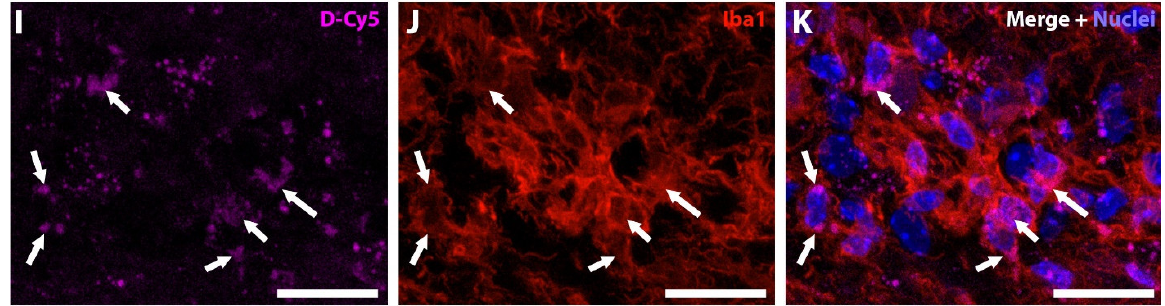
Figure 6. Dendrimer-Cy5 (D-Cy5) is targeted to areas of neuroinflammation. ( A – D ) Representative frontal cortex images showing no D-Cy5 signal ( A , magenta), with low microglial activation ( B , red), and no Thr181 tau expression ( C , green). Merged image with nuclei stained blue ( D ). ( E – H ) Repre- sentative hippocampal images showing the localization of D-Cy5 ( E ) to areas of microglial activation ( F ) of the dentate gyrus with Thr181 tau expression ( G ). Merged image with nuclei stained blue ( H ). ( A – H ) Scale bar 100 µm. ( I – K ) Higher magnification of the white boxed region in ( E – G ). D-Cy5 signal ( I ) localized to microglial cells ( J , white arrows). Merged image with nuclei stained blue shown in ( K ). ( I – K ) Scale bar 20 µm.